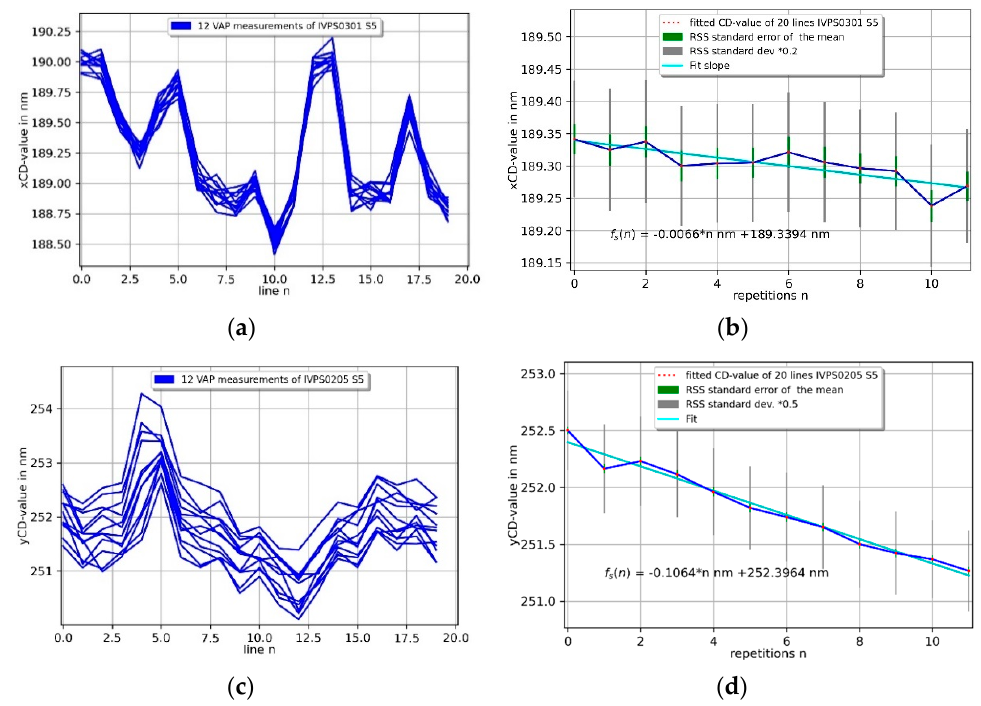
Figure 12. Repetition measurements of two orthogonally mounted IVPS100-PTB structures (IVPS0301 and IVPS0205). A total of 20 lines per measurement were taken and the CD-value is shown for each line on the left side by ( a ) and ( c ) and for each measurement by ( b ) and ( d ) on the right side, respectively. The average xCD value per measurement is shown on the right upper side (b)